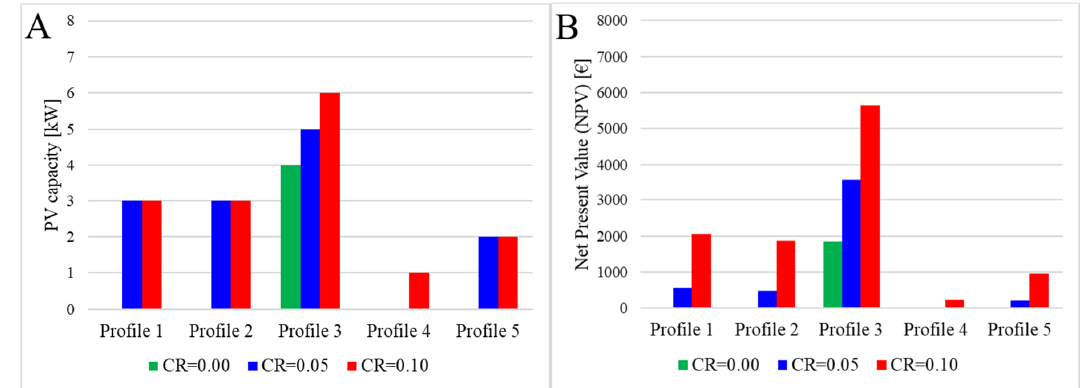
Figure 4. PV size ( A ) and NPV ( B ) in Bilbao, maximum profitability for different compensation rates (CRs, EUR/kWh).